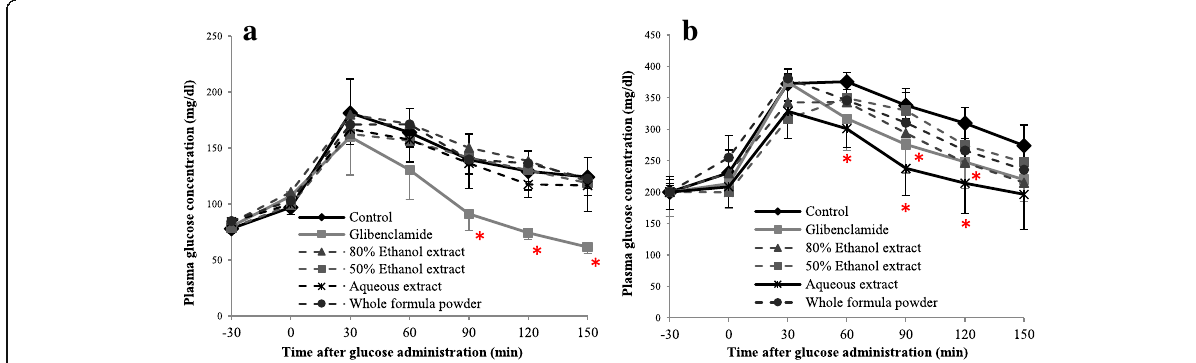
Fig. 1 Effects of the whole formula powder and extracts on oral glucose tolerance of a normal rats and b diabetic rats ( N = 5); *Significant different from control group ( p < 0.05 ; Student ’ s t-test); Data were expressed as mean ±